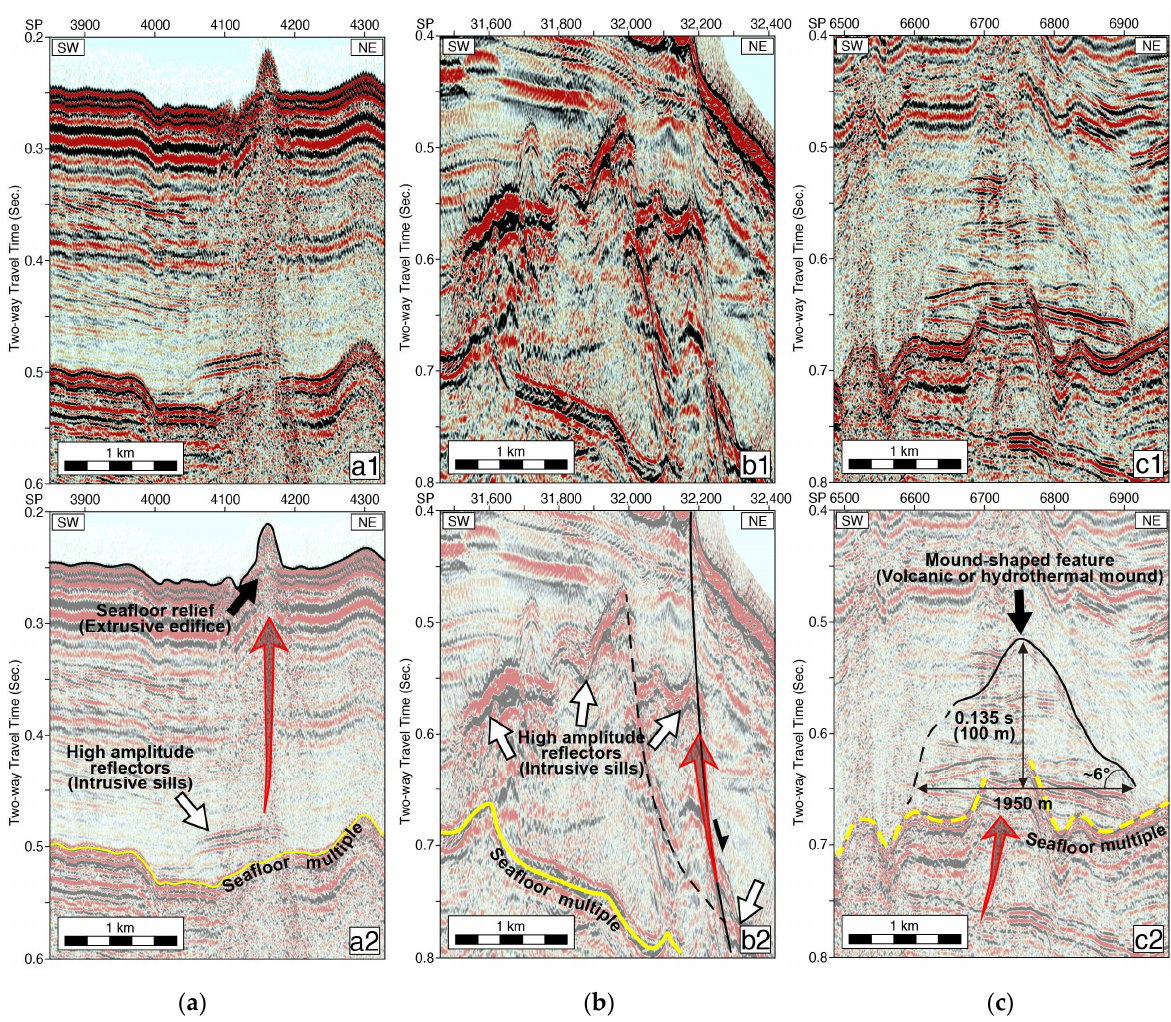
Figure 9. Close-up views of the volcanic-associated features in the Mianhua Terrace, including intrusive sills and corresponding extrusive edifice ( a ), intrusive sills with feeder fault structures ( b ), and the mound-shaped feature ( c ). See Sections 4.4, 4.5, and 4.6 for more details. (a1), (b1) and (c1) are uninterpreted data. (a2), (b2) and (c2) are interpreted data.